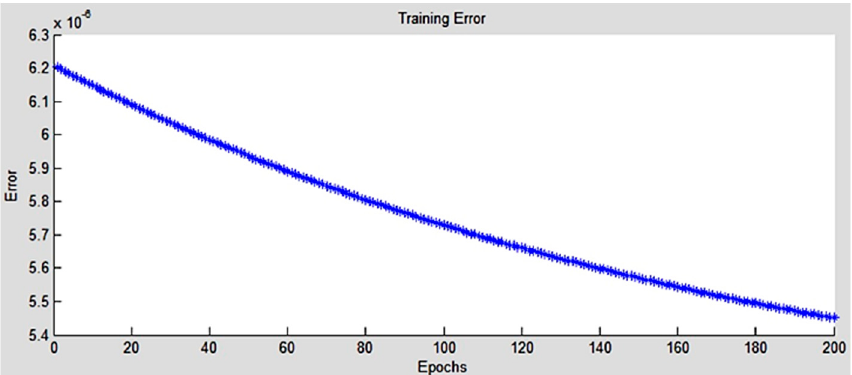
Figure 8. Training error.